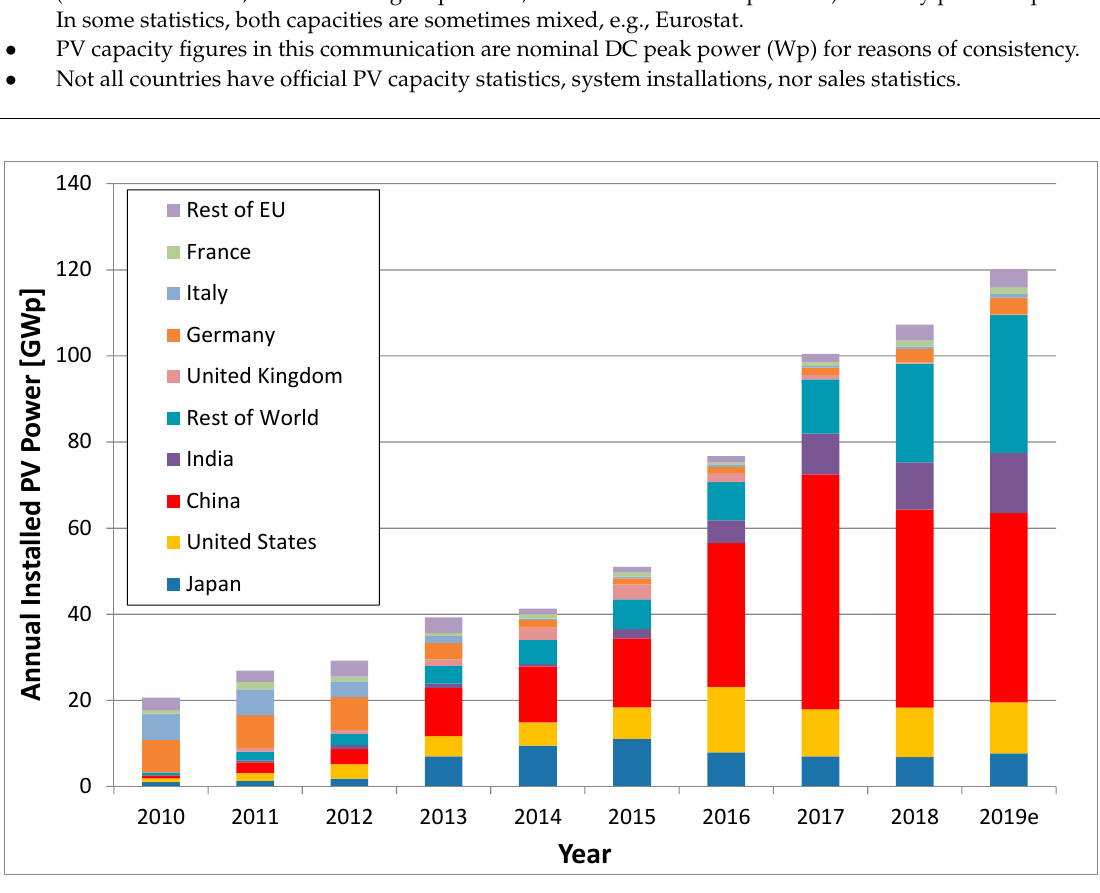
Figure 2. Annual photovoltaic installations from 2010 to 2019 (data source: [12–14], and own analysis). At the end of 2018, China was home to roughly one-third of global installed PV capacity (about 180 GW). The European Union was second with about 23% (or 117 GW), followed by the United States of America with 12% (or 63 GW) (Figure